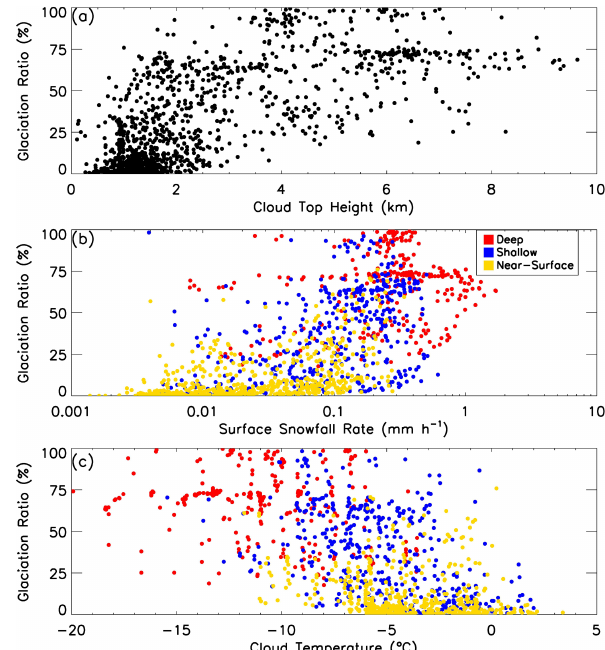
Figure 8. Two-dimensional distributions of (a) number of occur- rences, (b) the liquid water path, and (c) standard deviation of the liquid water path as a function of near-surface radar reflectivity and cloud top height. All observed data during the 2017–2018 winter are used to calculate the distributions.